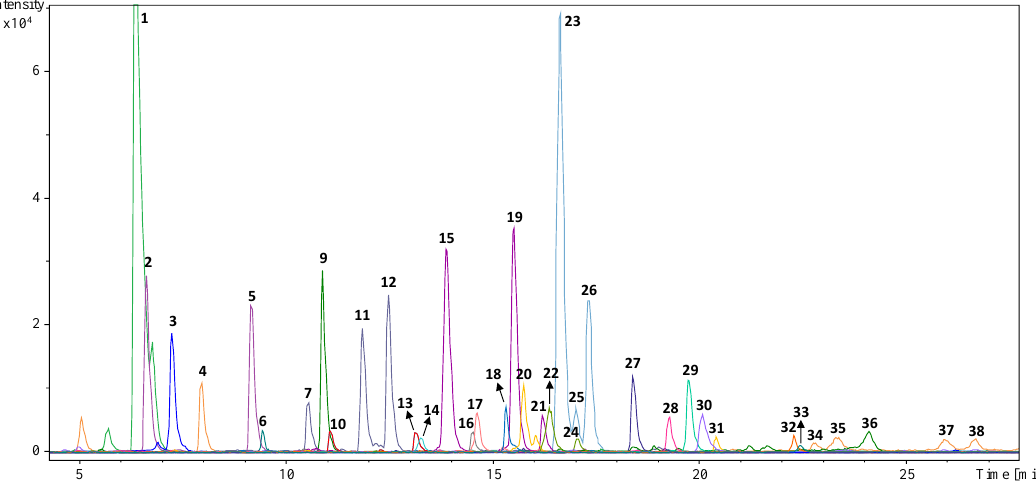
Figure 1. Extracted ion chromatograms (EICs) of the main phenolic compounds identified in a ‘Picholine Marocaine’ olive leaves sample. Numbers correspond with those included in Table 1.